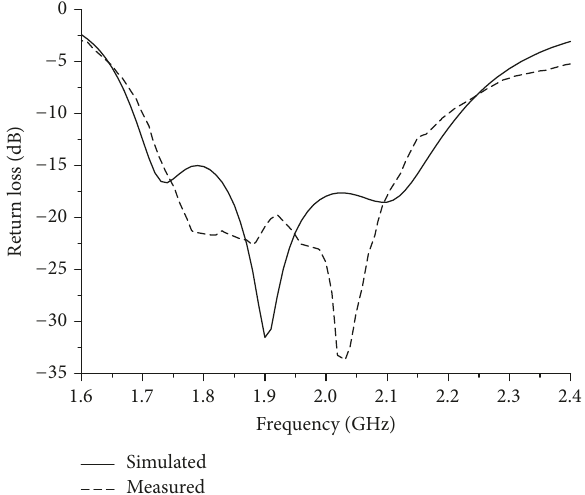
Figure 6: Return loss against frequency of the proposed DRA.